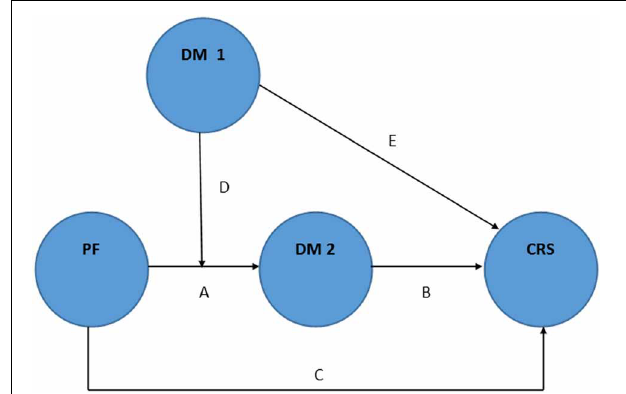
FIGURE 5 | Schematic representation of the general hypothesis: mindfulness as both moderator and mediator of the physical fitness effects on cardiovascular responses to stress (“D” represents “mediated moderation”). Adapted from Baron and Kenny (1986). PF: physical fitness. DM: dispositional mindfulness. CRS: cardiovascular responses to stress. DM 1: DM pre-intervention. DM 2: DM